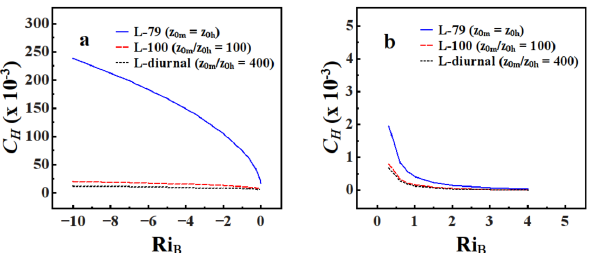
Figure 1. Sensitivity of the bulk transfer coefficient for heat ( C H ) Fig. 1. Sensitivity of the bulk transfer coefficient for heat ( C H ) with respect to the bulk Richardson number with respect to the bulk Richardson number ( Ri B ) for (a) unstable ( Ri B )for a unstable and b stableconditions oftheatmosphere. and (b) stable conditions of the